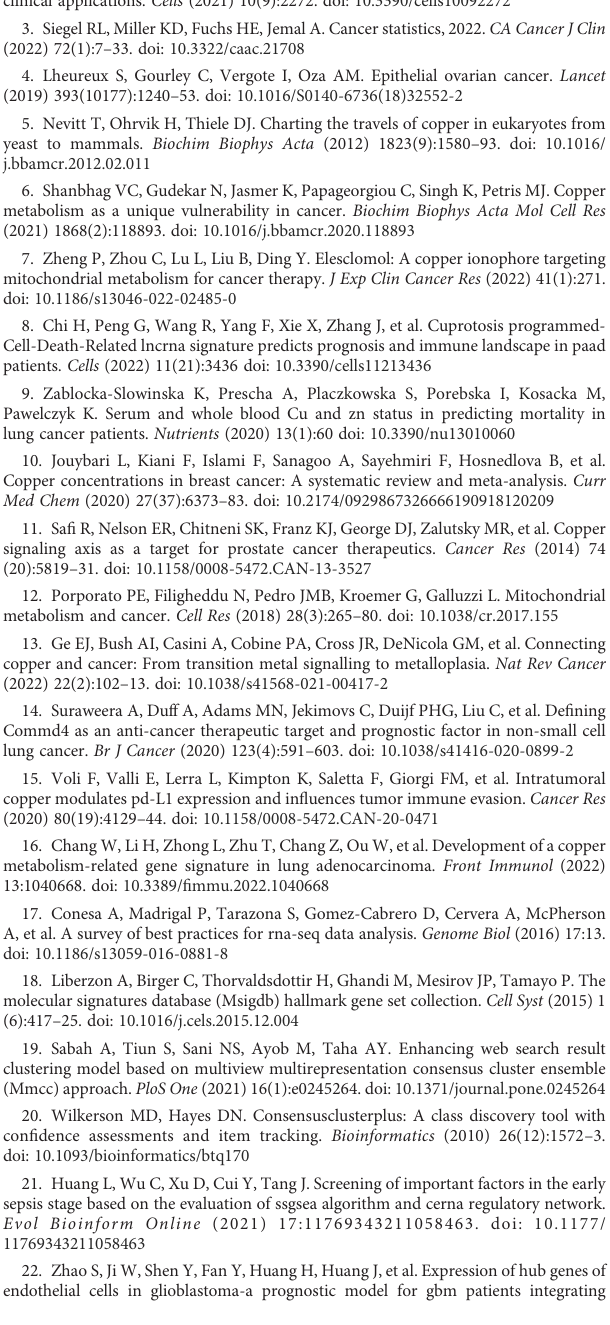
SUPPLEMENTARY TABLE 2 Univariate cox analysis and Kaplan-Meier survival analysis were used to select genes associated with copper metabolism that have prognostic signi fi cance for OC. SUPPLEMENTARY TABLE 3 Queue information obtained for the two CM clusters.